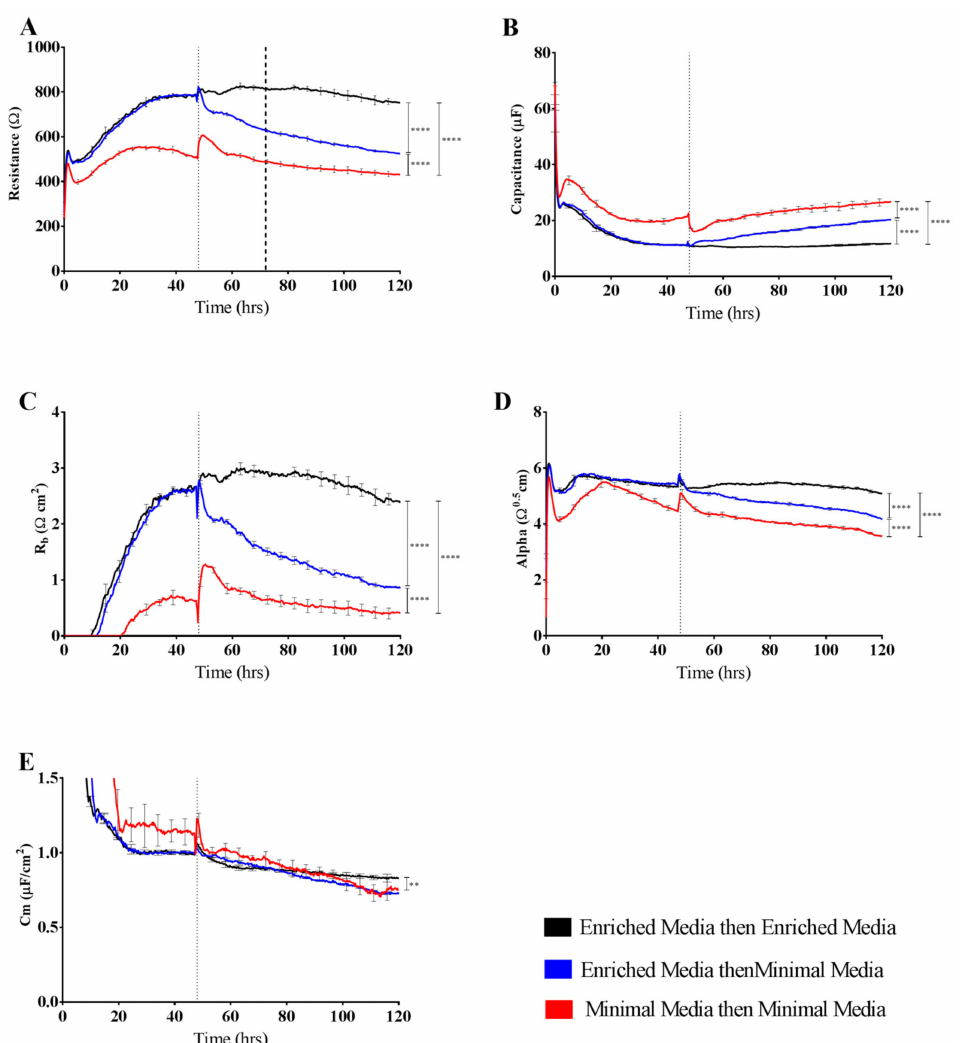
Figure 4. Resistance and modelled parameters R b , α , and C m of brain endothelium grown in either Enriched Media or Minimal Media. Endothelial cells were seeded at 20,000 cells per well on a 96w20idf ECIS array. Time 0 h denotes the time cells were seeded. The dotted vertical line indicates 48 h of cell growth in each respective media type, with a subsequent media change carried out at this time. ( A ) Resistance at 4000 Hz trace over 120 h of cell growth; ( B ) Raw capacitance trace over 120 h of cell growth; ( C ) Modelled parameter, R b , trace over 120 h of cell growth; ( D ) Modelled parameter, α , trace over 120 h of cell growth; ( E ) Modelled parameter, C m , trace over 120 h of cell growth. Data show the mean ± SD (n = 3 wells) of one independent experiment representative of three experimental repeats. Graphical representations of p values are * p ≤ 0.05, ** p ≤ 0.01, *** p ≤ 0.001, **** p ≤